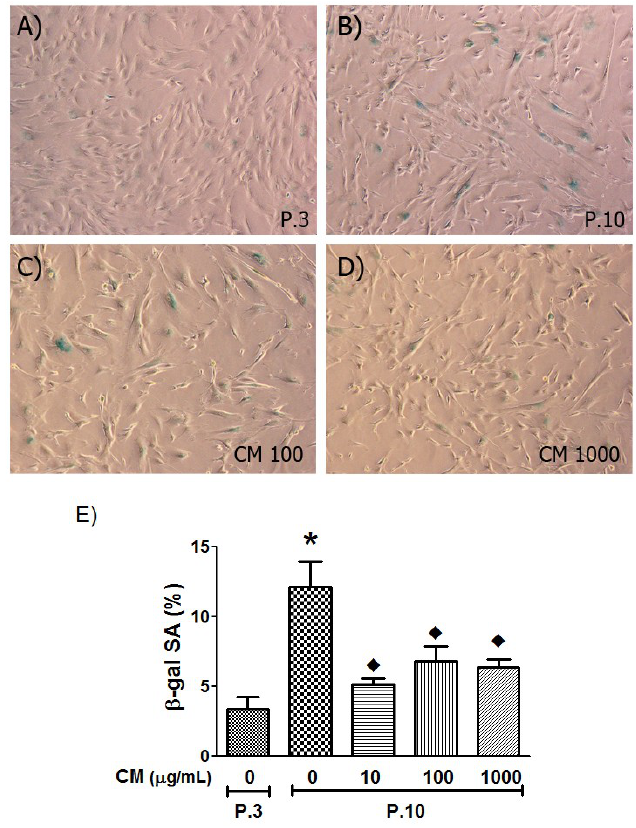
Figure 5. Senescence associated beta-galactosidase (SA-β-gal) staining of HUVECs. ( A ) to ( D ) (40× objective lenses) at Passage 3 (P.3) and Passage 10 (P.10) with or without CM (100, 1000 μg/mL) treatment as indicated in the figures. ( E ) Proportion of SA-β-gal positive staining in HUVECs in young cells (P.3) and aged cells (P.10) with or without CM co-culture. * p < 0.05, P.3 vs. P.10 non-treated groups (0 μg/mL);  , p < 0.05, P.10 non-treated group vs. P.10 treated with CM 1000